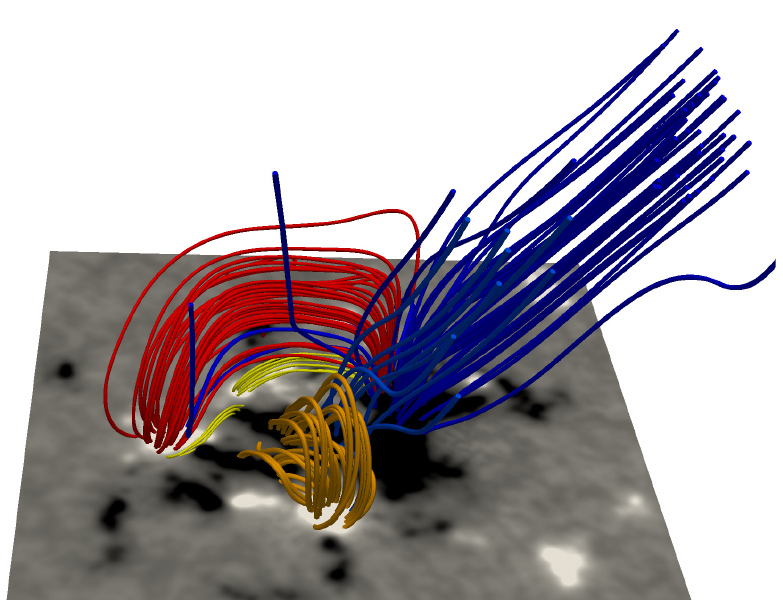
Figure 9. NLFFF extrapolation of 25 December 2011 at 08:36 UT. The yellow lines outline the structures, which are consistent with the two small filaments. The red lines represent the overlaying magnetic field. Blue lines are the opened magnetic field, and orange lines represent other closed magnetic